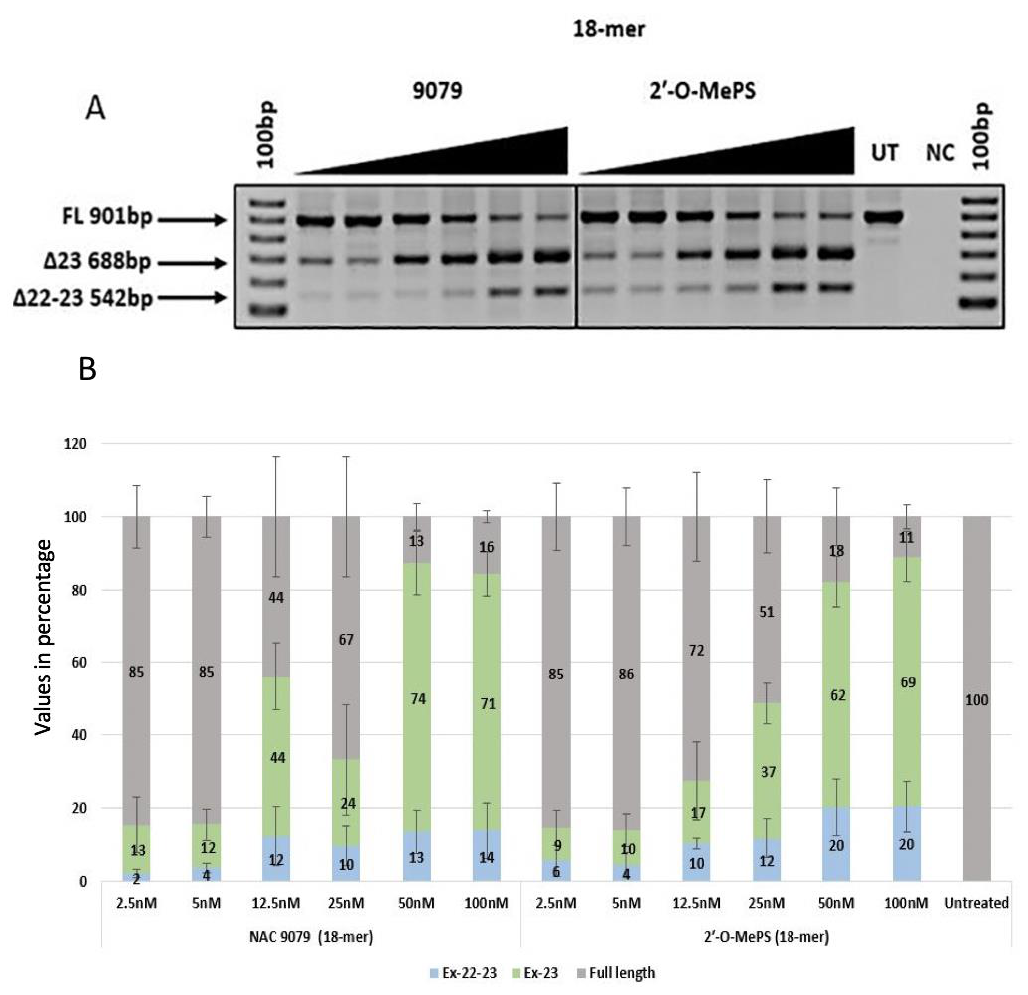
Figure 3. ( A ) RT-PCR analysis of exon-23 skipping induced by AO NAC 9079 and the